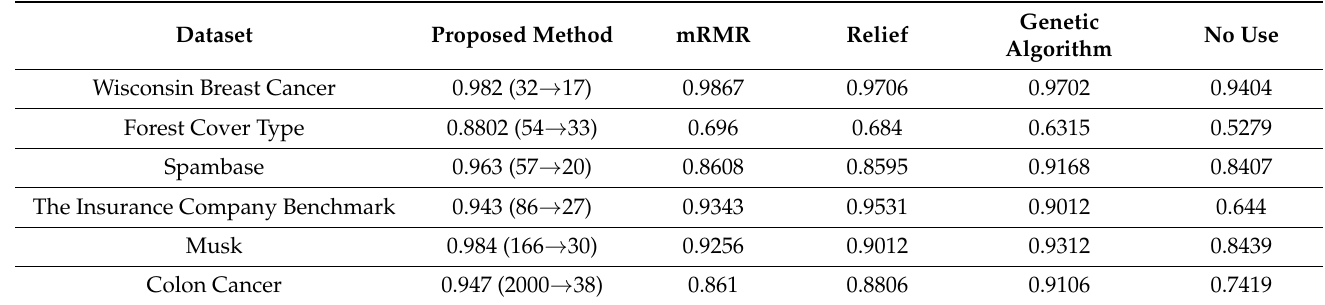
Table 2. Experiment results for each dataset using the proposed method and other feature selec- tion